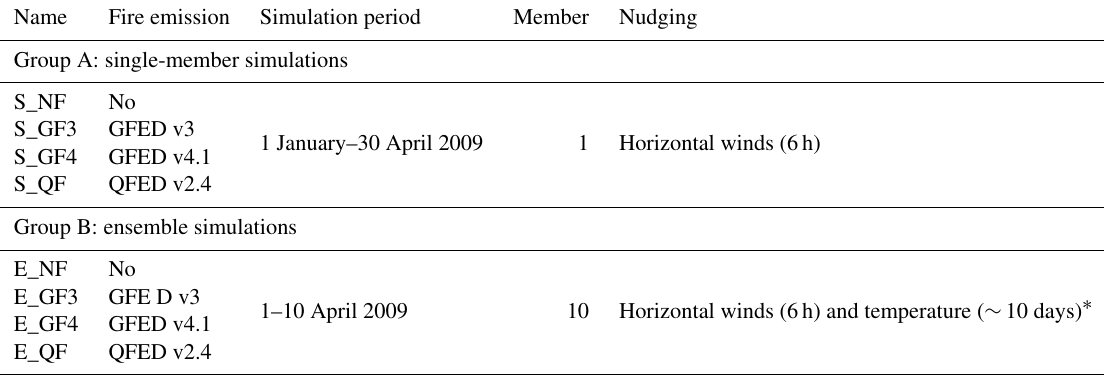
Table 1. List of CAM5